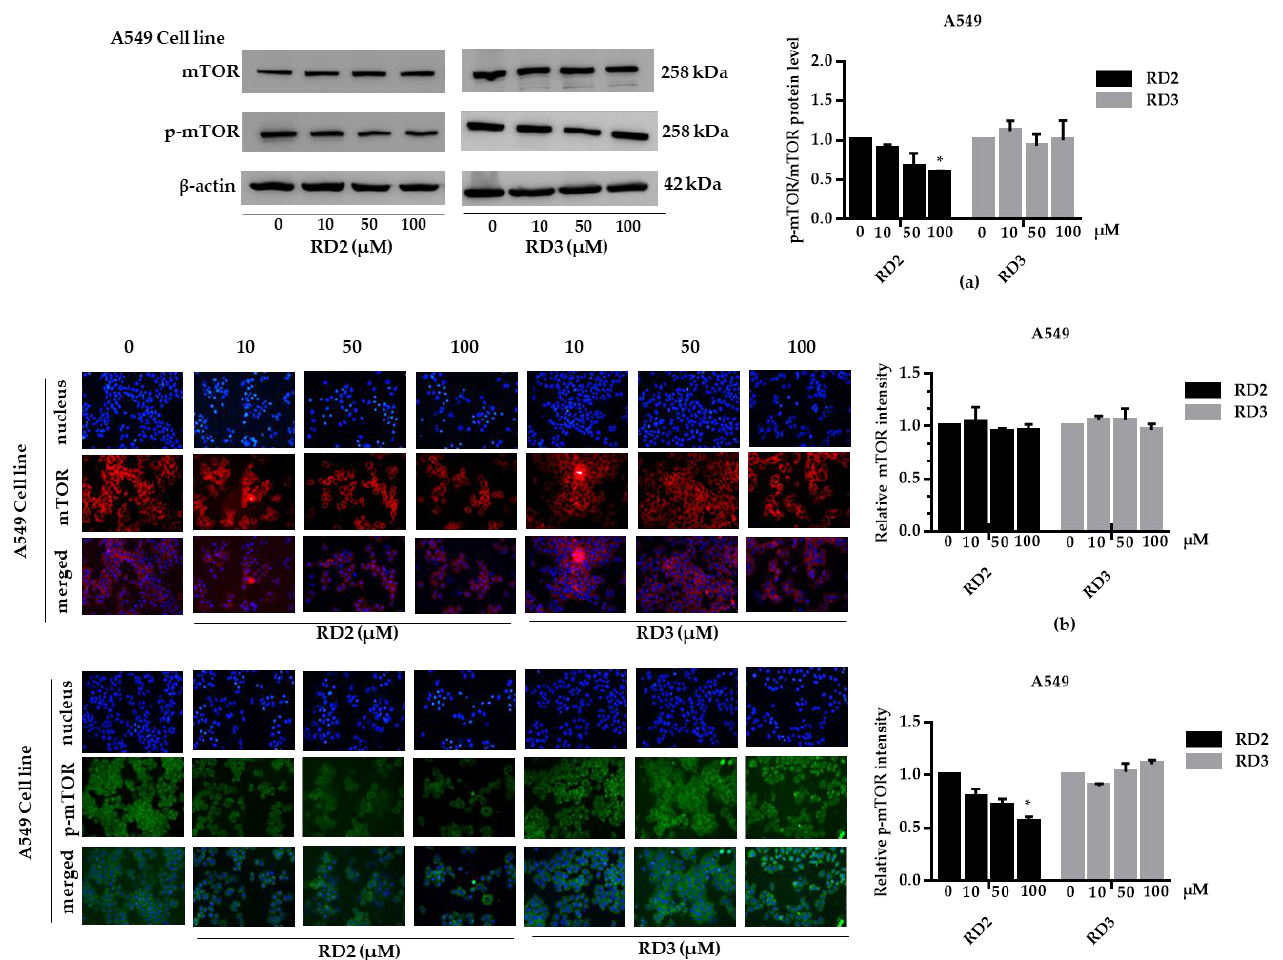
Figure 5. RD2 downregulates p -mTOR in NSCLC cells (A549). The cells were treated with RD2 and RD3 (0 – 100 μM ) for 24 h. ( a ) Western blot analysis was performed to measure the p -mTOR/mTOR- related proteins. β -Actin protein was evaluated to confirm the equal loading of each protein sample.